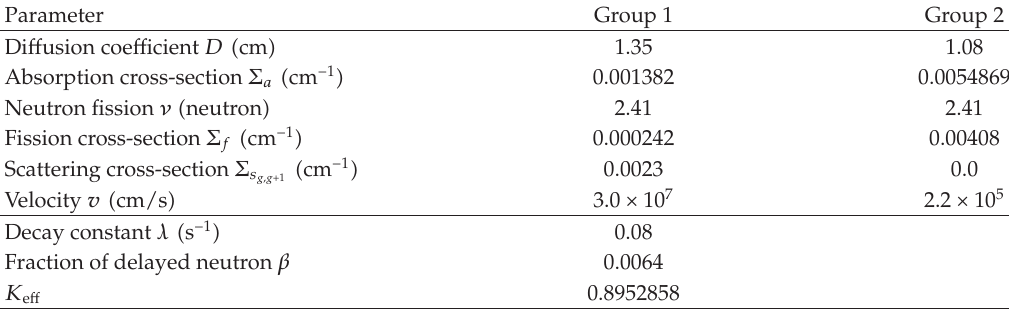
Table 2: Thermal neutron flux at the center point of three-dimensional homogeneous reactor with a positive step reactivity.